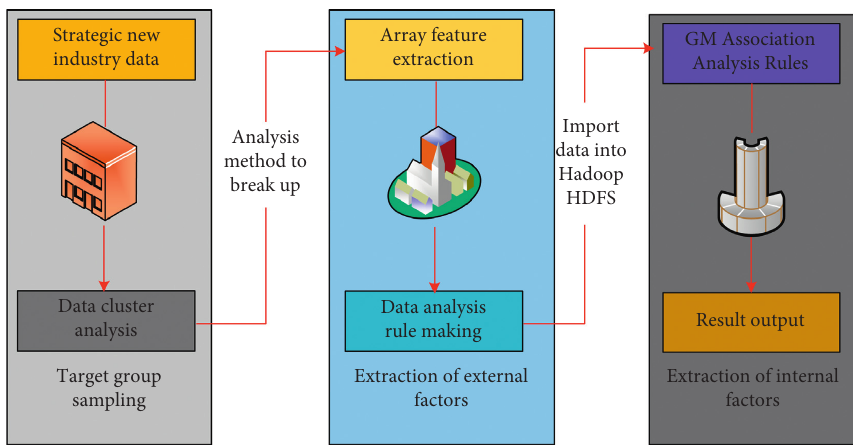
Figure 1: Data analysis process of GM correlation method.